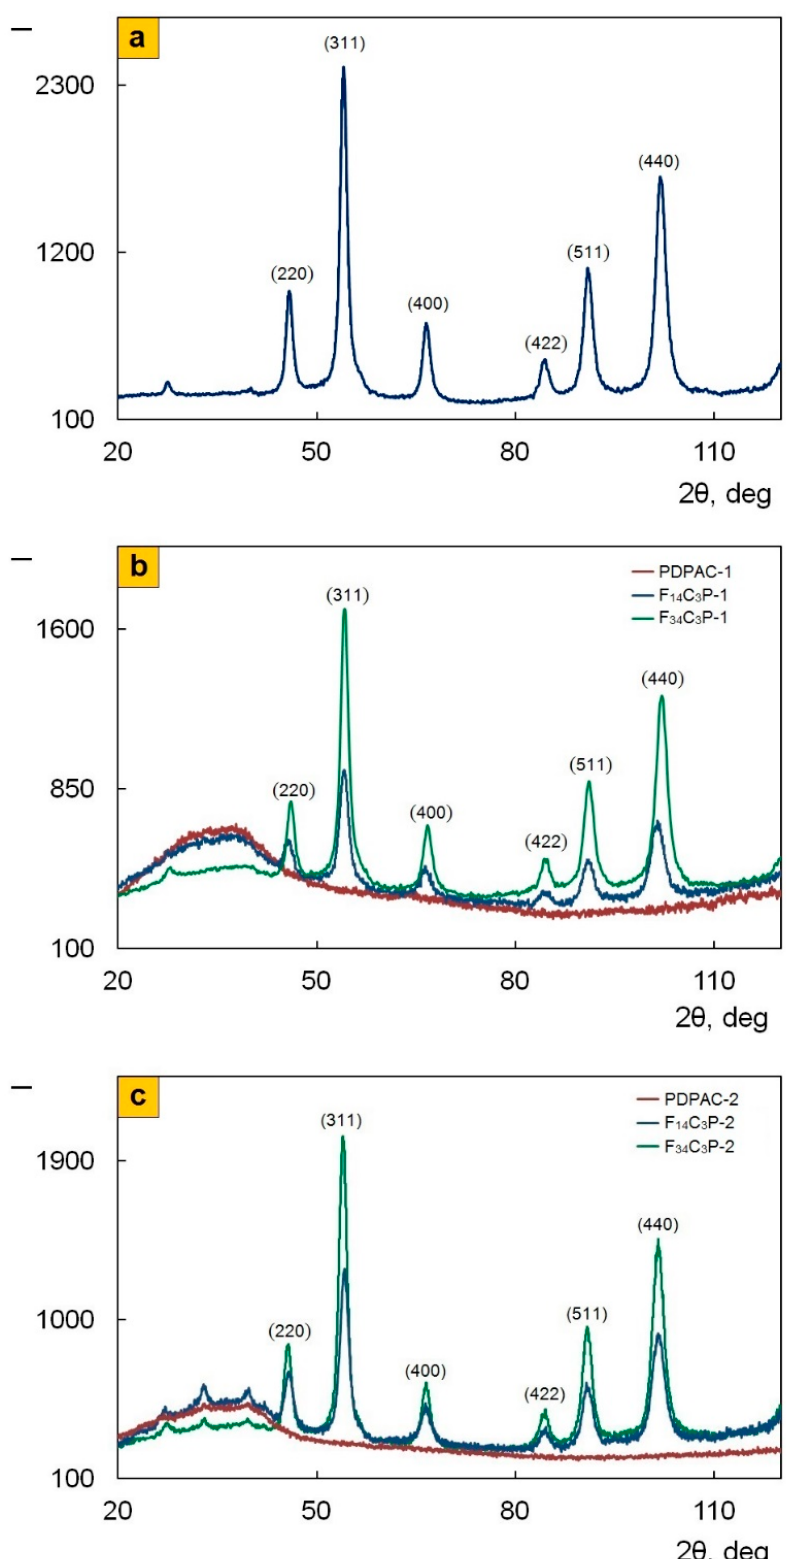
Figure 2. X-ray di ff ractograms of Fe 3 O 4 / SWCNT ( a ), PDPAC, and Fe 3 O 4 / SWCNT / PDPAC, prepared in Figure 2. X-ray diffractograms of Fe 3 O 4 /SWCNT ( a ), PDPAC, and Fe 3 O 4 /SWCNT/PDPAC, prepared alkaline ( b ) and acidic media ( c in alkaline ( b ) and acidic media ( c ).